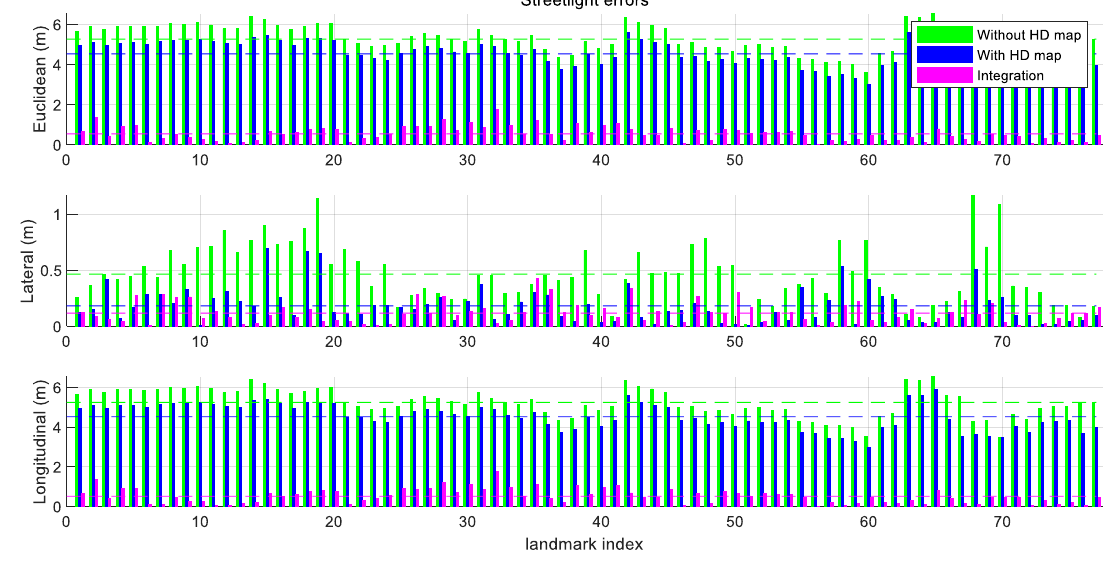
Figure 10. Errors of estimated streetlights. (top) the Euclidean error, (middle) the lateral error, and (bottom) the longitudinal error of the streetlights. The lateral errors are reduced based on the matching with the HD map. The longitudinal errors are reduced by considering the crowd-sourced data.